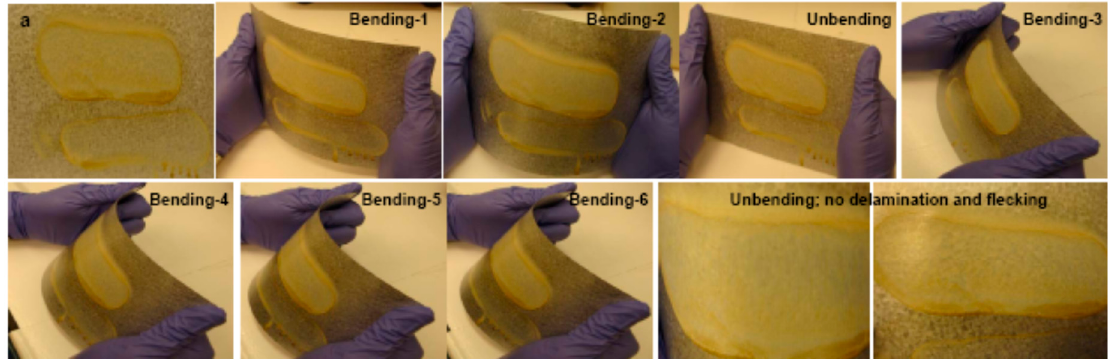
Figure 10. Photographs of bending–unbending of large-area thin films of P-1 on tin substrates prepared by spray coating from methanol solution.